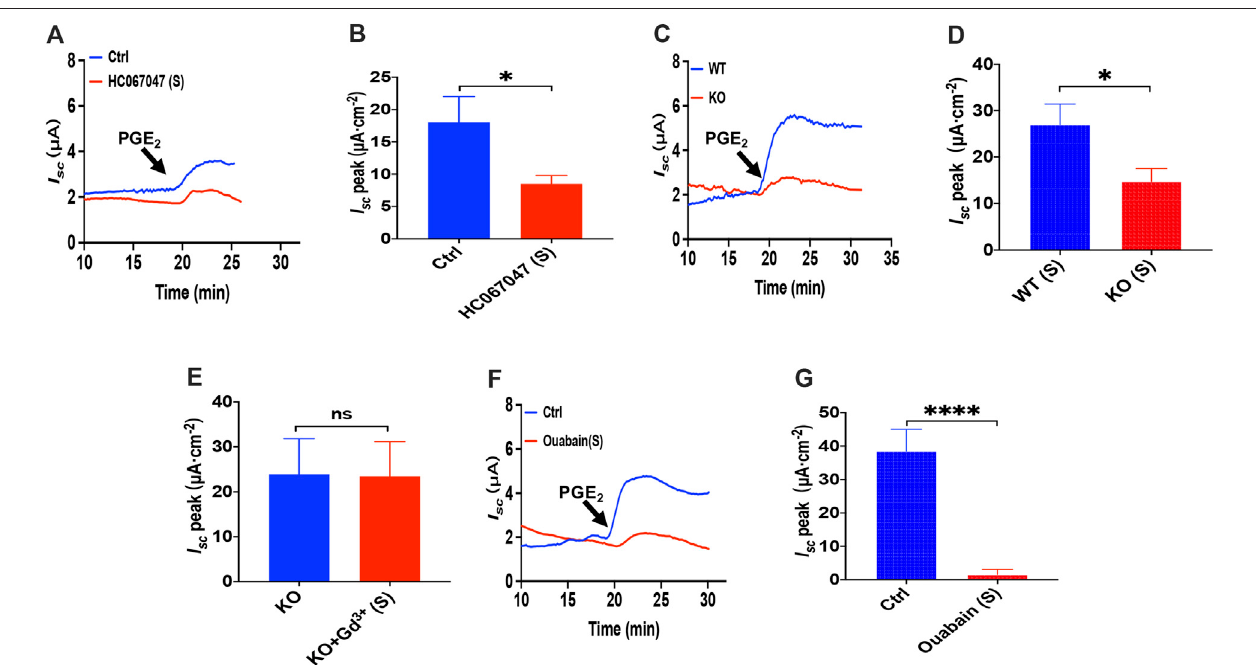
FIGURE4| PGE 2 inducedduodenalionsecretionbyserosalTRPV4channelsandNKA. (A,B) onPGE 2 -evoked I sc afterHC067047(30 μ M, n (cid:2) 6)addedinserosal (s) side. (C,D) PGE 2 (10 μ M) -evoked duodenal I sc inwild-type (W.T.) andTRPV4knockout(K.O.)mice ( n (cid:2) 6). (E) PGE 2 -evoked I sc after GdCl 3 (Gd 3+ ,30 μ M, n ≥ 6)was added to the serosal (s) side of the TRPV4 KO mice duodenum. (F,G) PGE 2 -stimulated I sc after Ouabain (1 mM, n (cid:2) 7) was added to the serosal (s) side. Ctrl represents the control without drug treatment. Results are presented as mean ± SE. * p < 0.05, **** p < 0.0001 signi fi cantly different from the corresponding control by Student ’ s unpaired, two-tailed